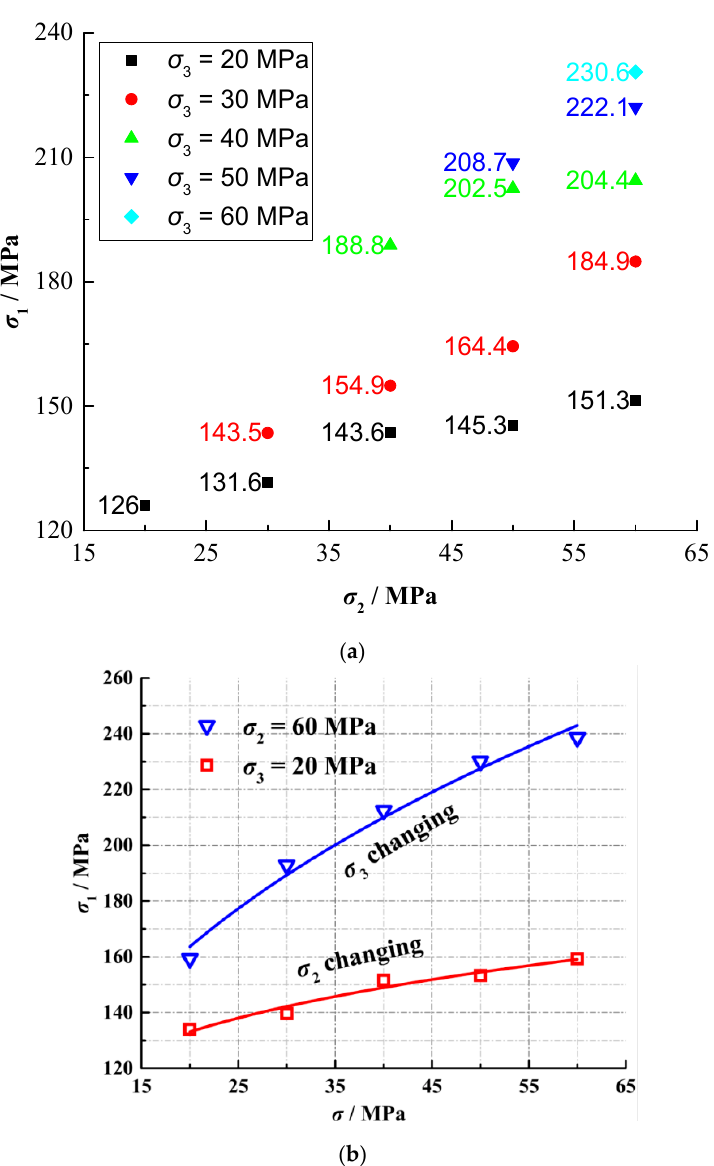
Figure 4. Relationship between strength and σ 2 and σ 3 . ( a ) Strength results under different σ 2 and σ 3 values; ( b ) different variation patterns in rock strength with changing σ 2 and σ 3 .